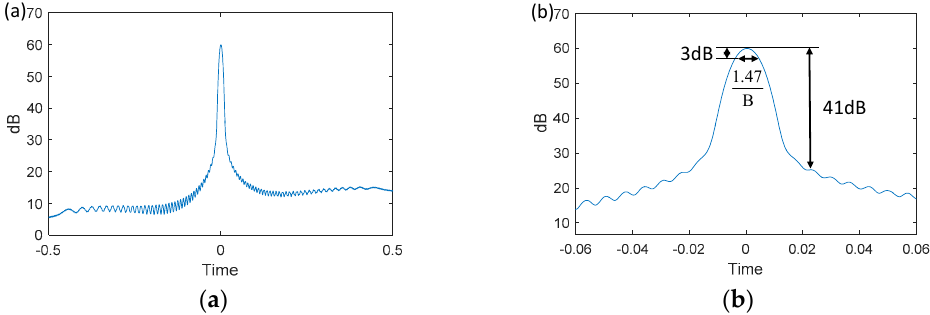
Figure 4. STFrFT with the Hamming window (time normalizes with respect to T). ( a ) Compressed narrow pulse by STFrFT and ( b ) zoom-in of the main lobe in (a) with a 3-dB width, which is equal to 1.47/ KT , and a peak sidelobe ratio of approximately 41 dB.